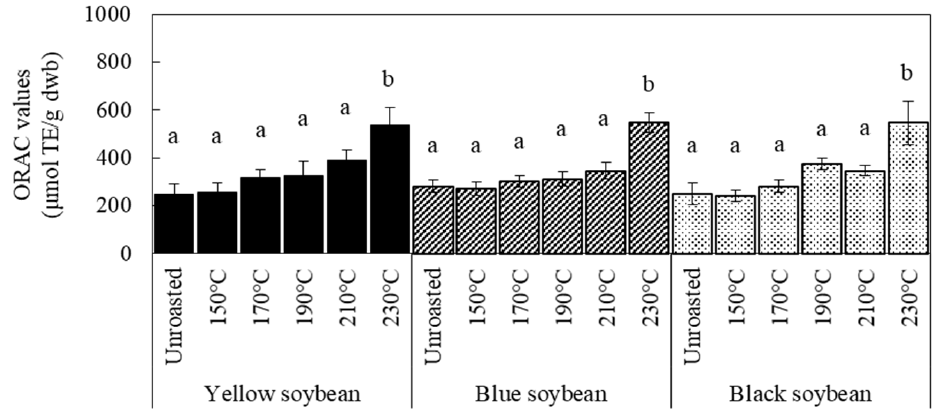
Figure 2. Effect of roasting temperatures on ORAC values of soybeans. Sample soybeans were stored at 4 °C. Significant differences within the same bean are indicated by lowercase letters a, b, and c. p < 0.05. n = 3.